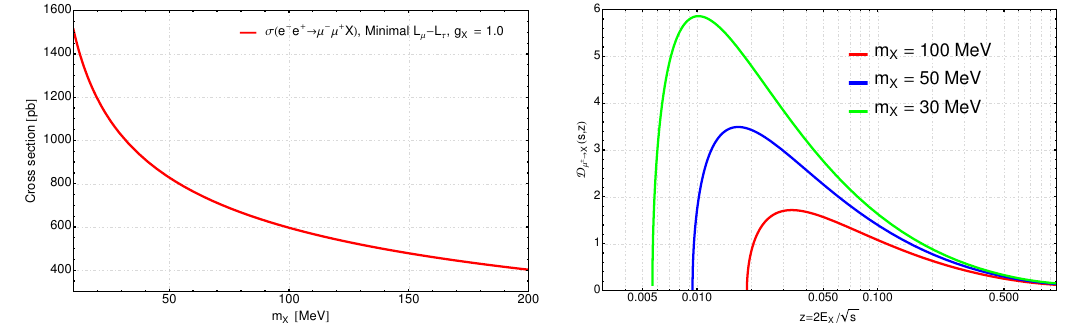
Figure 4 . (Left) The signal cross section (cid:27) ( e (cid:0) e + g X = 1. (Right) The splitting function